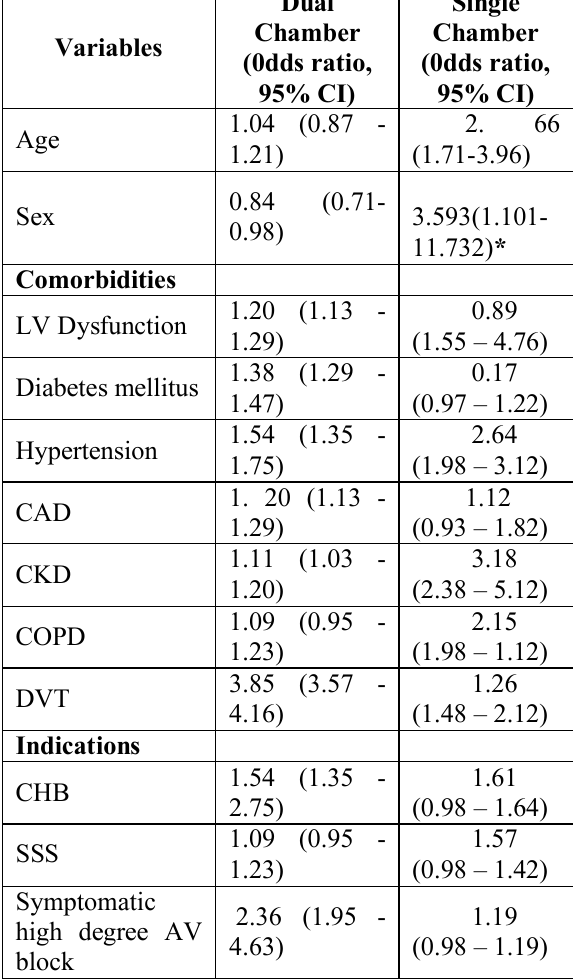
Table 1: Baseline characteristics Characteristics